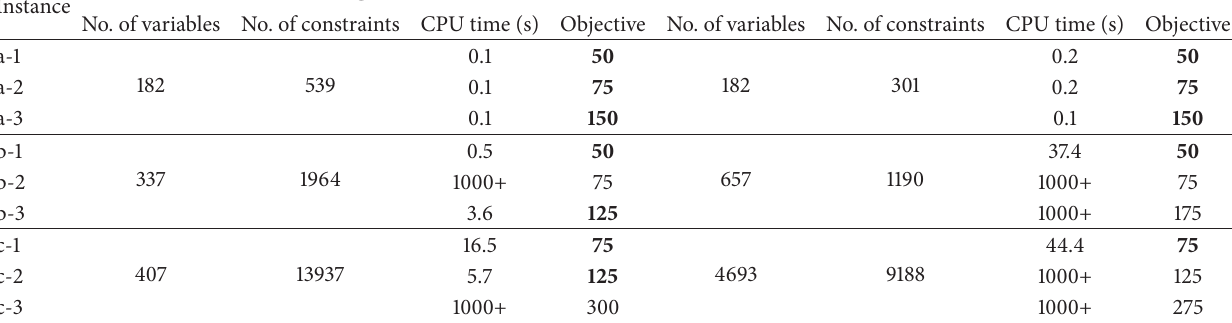
Table 3: Comparison of CP and MIP models.